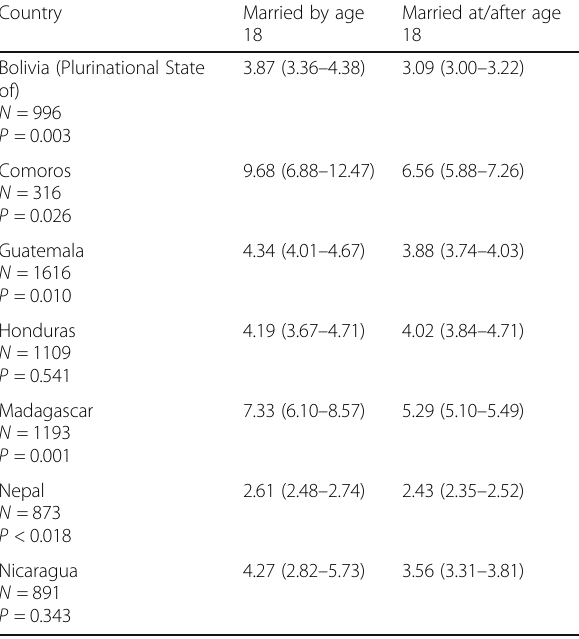
Table 8 The mean number of children desired among ever- married men currently aged 40 – 49, by men ’ s age at marriage